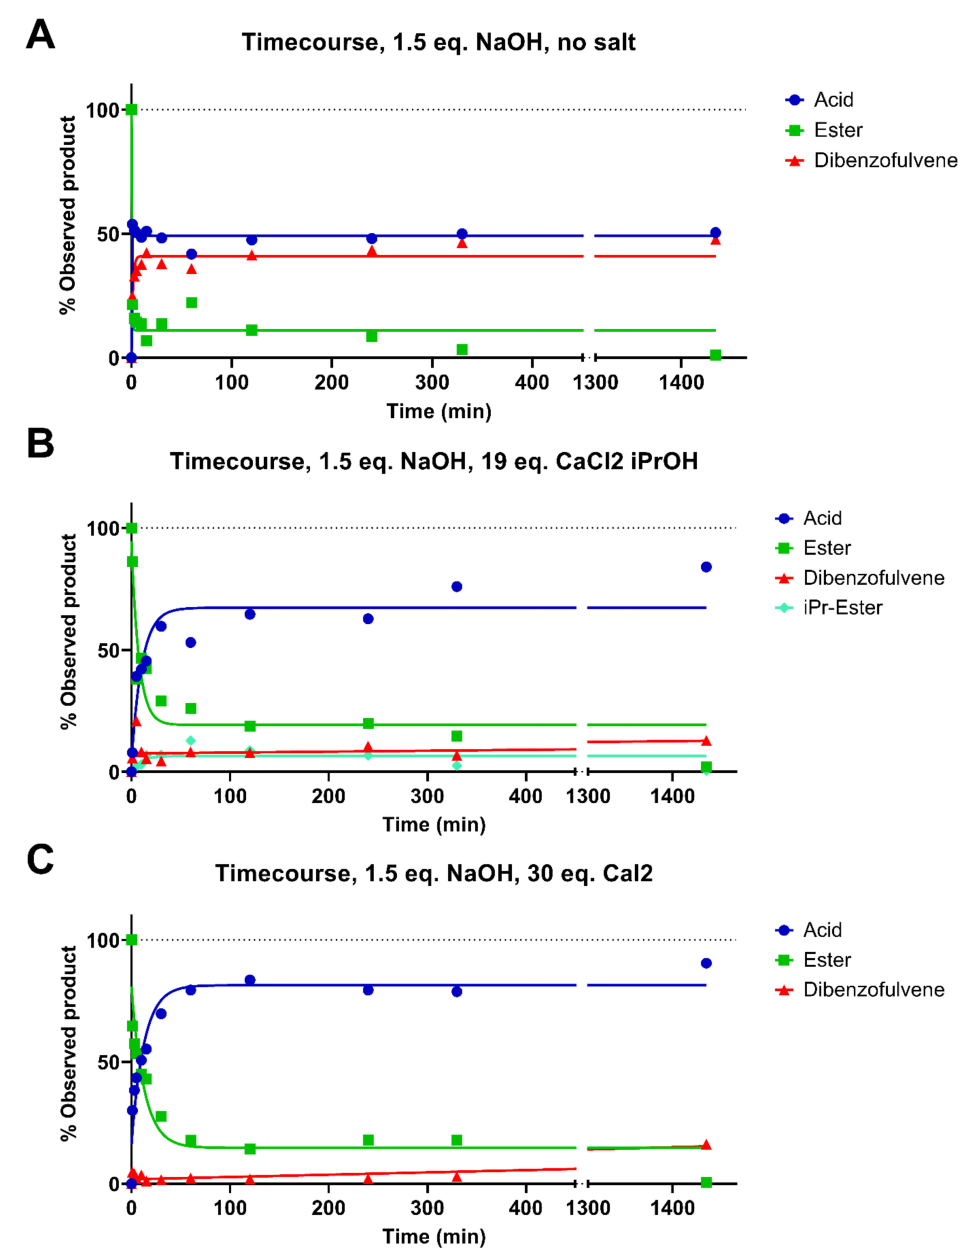
Figure 5. Time course of hydrolysis using 44 mM of Fmoc-Gly-OMe, 1.5 eq. of NaOH at RT: ( A ) no salt in acetone/H 2 O (2.3:1); ( B ) 19 eq. of CaCl 2 in iPrOH/H 2 O (2.3:1) as previously described by Pascal et al. [3]; ( C ) 30 eq. of CaI 2 in acetone/H 2 O